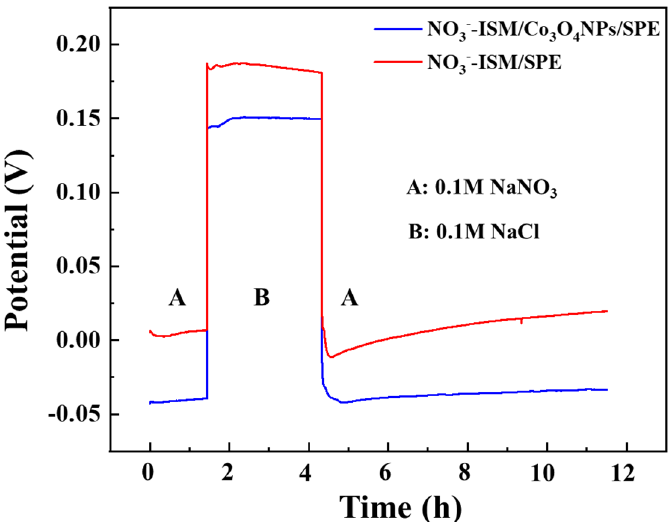
Figure 8. Potentiometric water layer tests of NO 3 − -ISM/Co 3 O 4 NPs/SPE (blue) and NO 3 − -ISM/SPE (red). The measurements were completed by switching the electrodes between 0.1 M NaNO 3 and 0.1 M NaCl solutions.